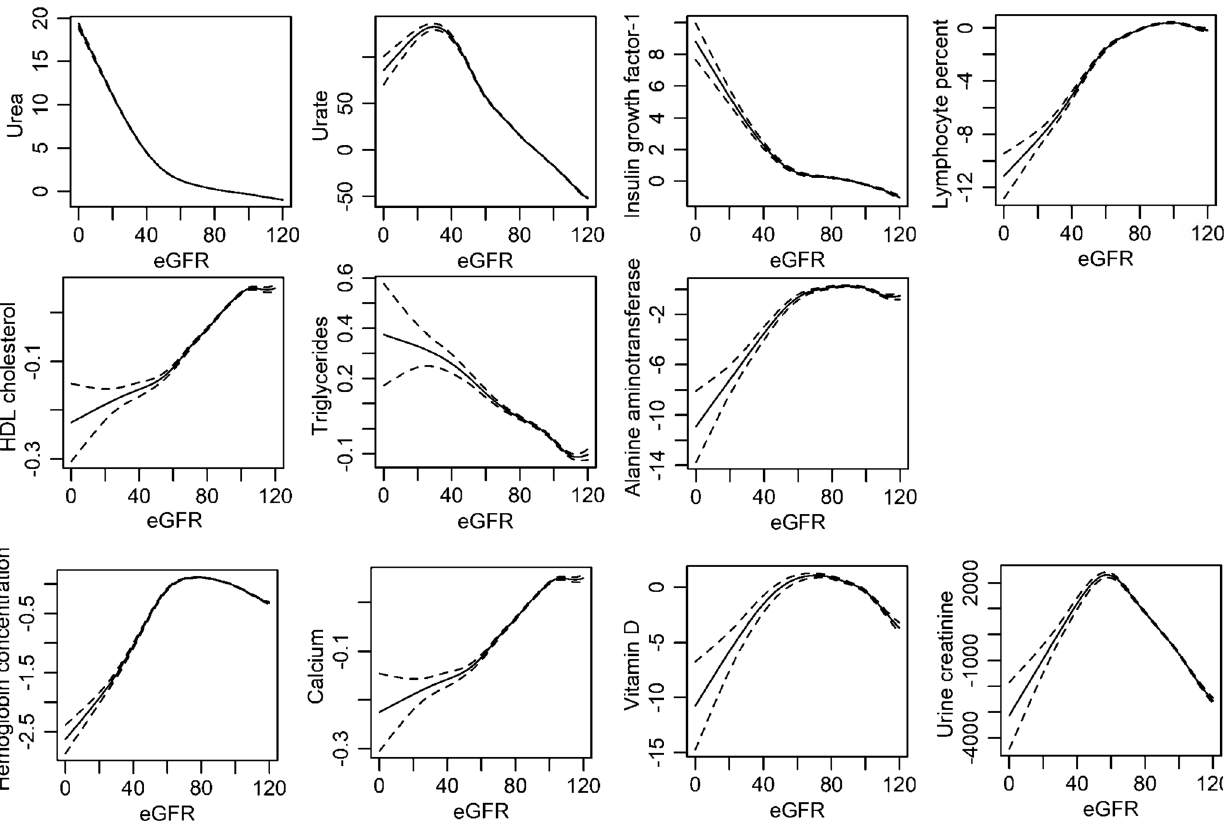
Fig. 4 Cross-sectional, observational associations between eGFR and biochemical parameters. The generalized additive model adjusted for age, sex, and body mass index was used to plot the shapes of the observational associations. The eGFR values were calculated based on the creatinine – cystatin C CKD- EPI equation in the UK Biobank (available in 321,024 individuals). The Y -axes indicate the values predicted by the generalized additive model. The biochemical parameters for which the causal estimates were consistently signi fi cant in the summary-level MR were assessed by cross-sectional observational analysis. The dashed-lines indicate the 95% con fi dence intervals. The unit of eGFR was mL/min/1.73 m 2 , and the unit of measurements